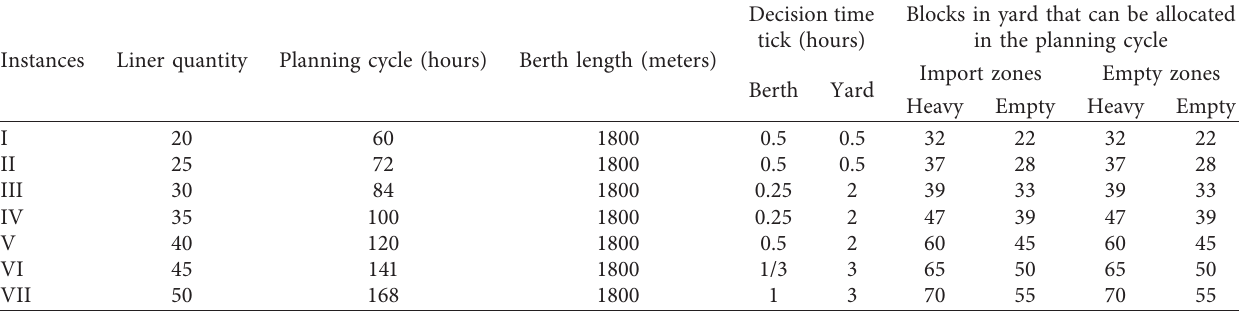
Table 1: The basic formation of each testing instance.